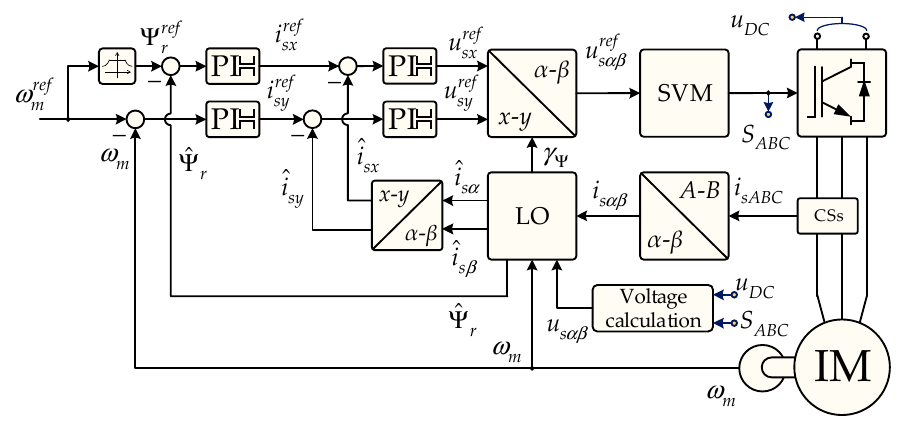
Figure 2. Scheme of the DRFOC structure with LO.